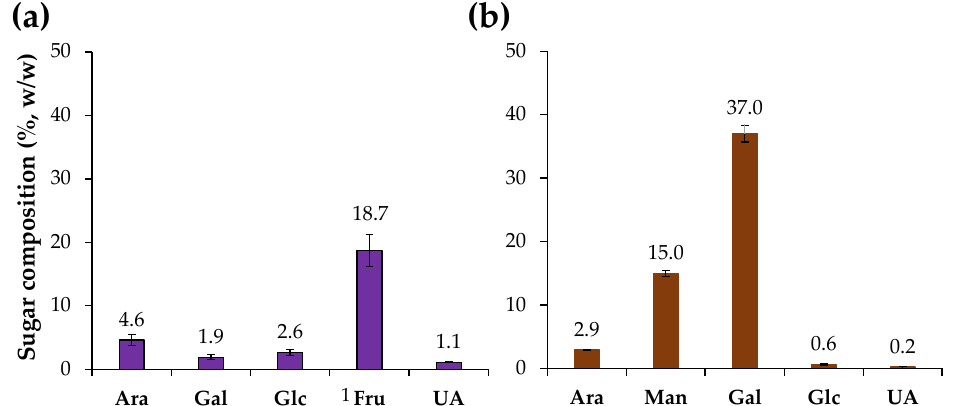
Figure 1. Sugar composition (%, w / w ) of chicory ( a ) and coffee ( b ) high molecular weight material. 1 Fru was estimated as the sum of mannitol and glucitol using its epimerization ratio during the reduction step [30]. Sugar residues: Ara—arabinose, Man—mannose, Gal—galactose, Glc—glucose, Fru—fructose, and UA—uronic acids. Table 1. General composition of the high molecular weight material (HMWM) of instant chicory and instant coffee.